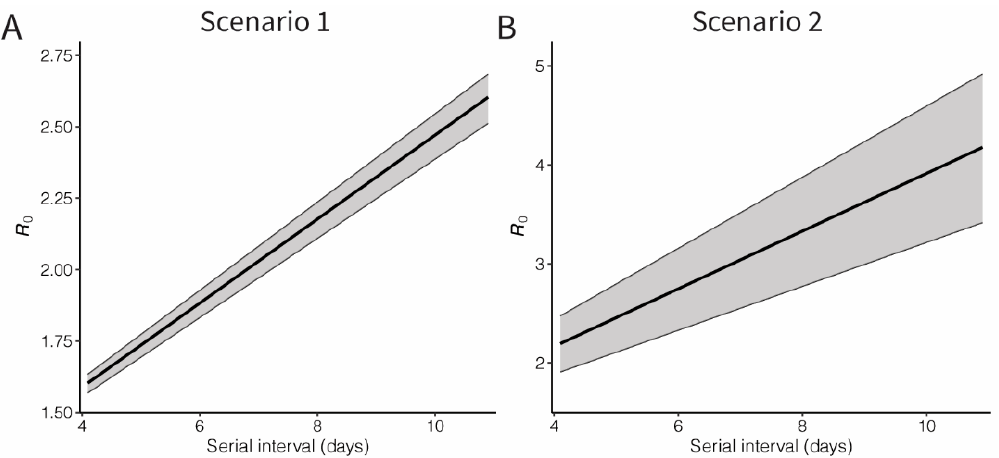
Figure 3. Basic reproduction number of novel coronavirus (COVID-19) infections in China, 2020. Black lines and grey shades represent the median and 95% credible intervals of the basic reproduction number. Panel A shows the result of Scenario 1, in which an exponential growth started from the assumed illness onset date of index case, while Panel B shows the result from exponential growth from the first exported case (Scenario 2). The 95% credible intervals were derived from Markov chain Monte Carlo method.